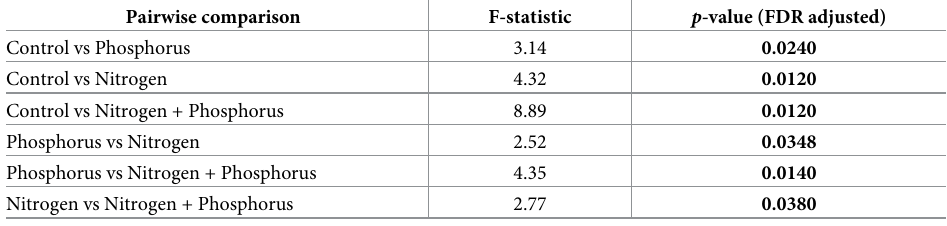
Bolded values indicate significant differences ( p -value <